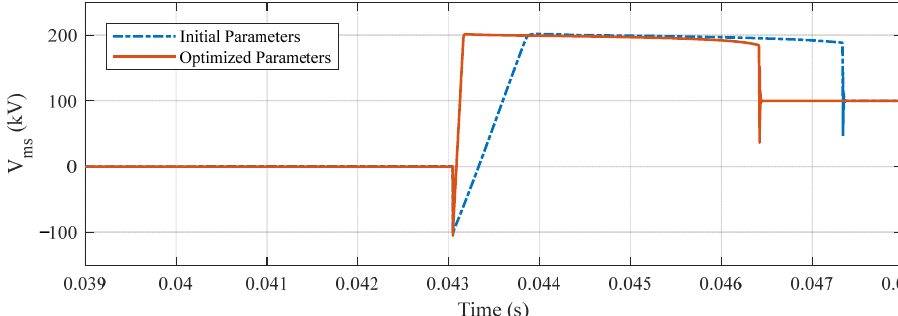
Figure 9. Voltage waveform of MS in branch 1 of the HCB.